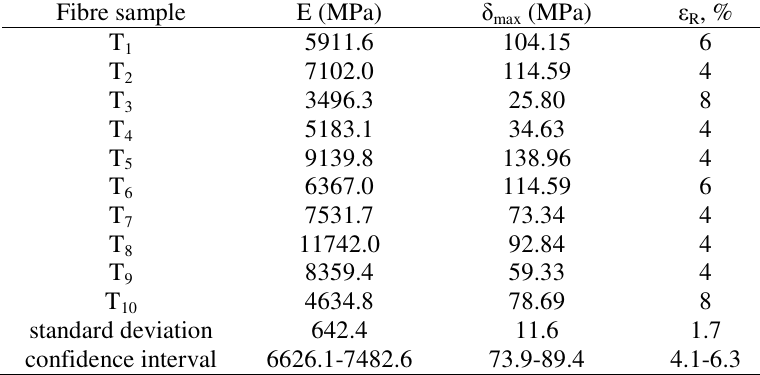
Table 1. Mechanical properties of banana